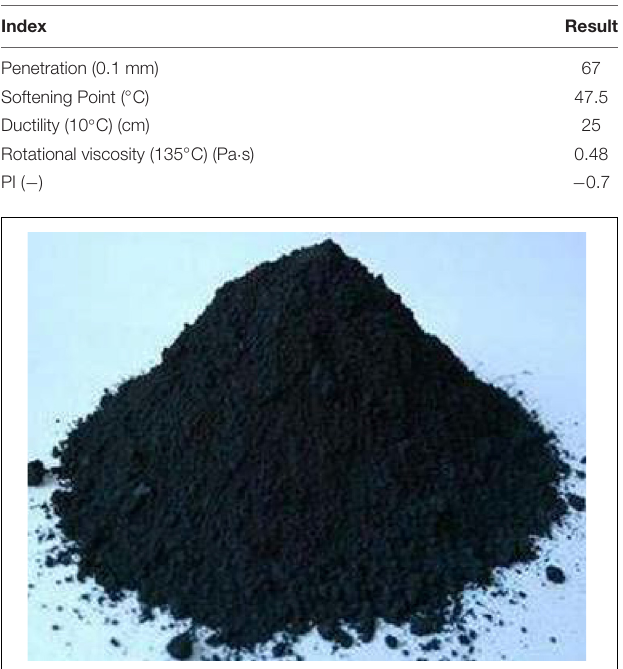
FIGURE 1 | CNFs used in this